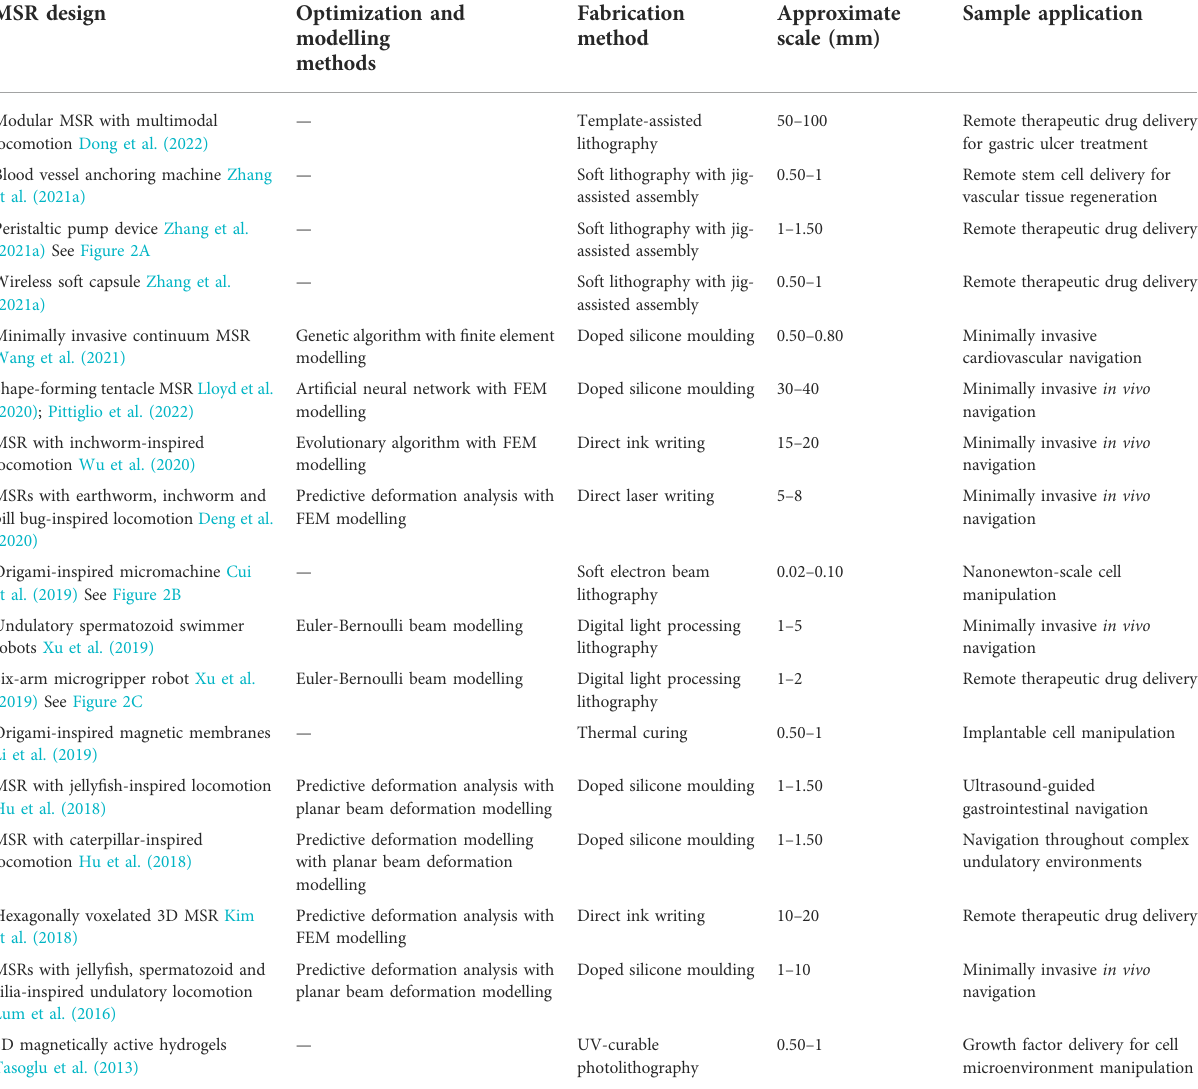
TABLE 1 Signi fi cant programmable MSR developments for biomedical application. Includes numerous bio-inspired designs. Summarizes developments, fabrication methods, optimization and modelling methods, approximate scales and sample applications of MSRs within key and supporting literature. A dash under ‘ Optimization and Modelling Methods ’ indicates that no methods were sourced in literature, or reported to have been developed, applied or investigated with respect to the highlighted MSR